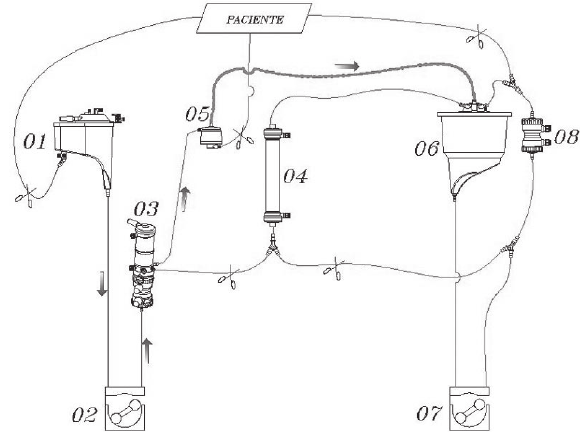
Fig. 2A - Transporte do volume residual do circuito para